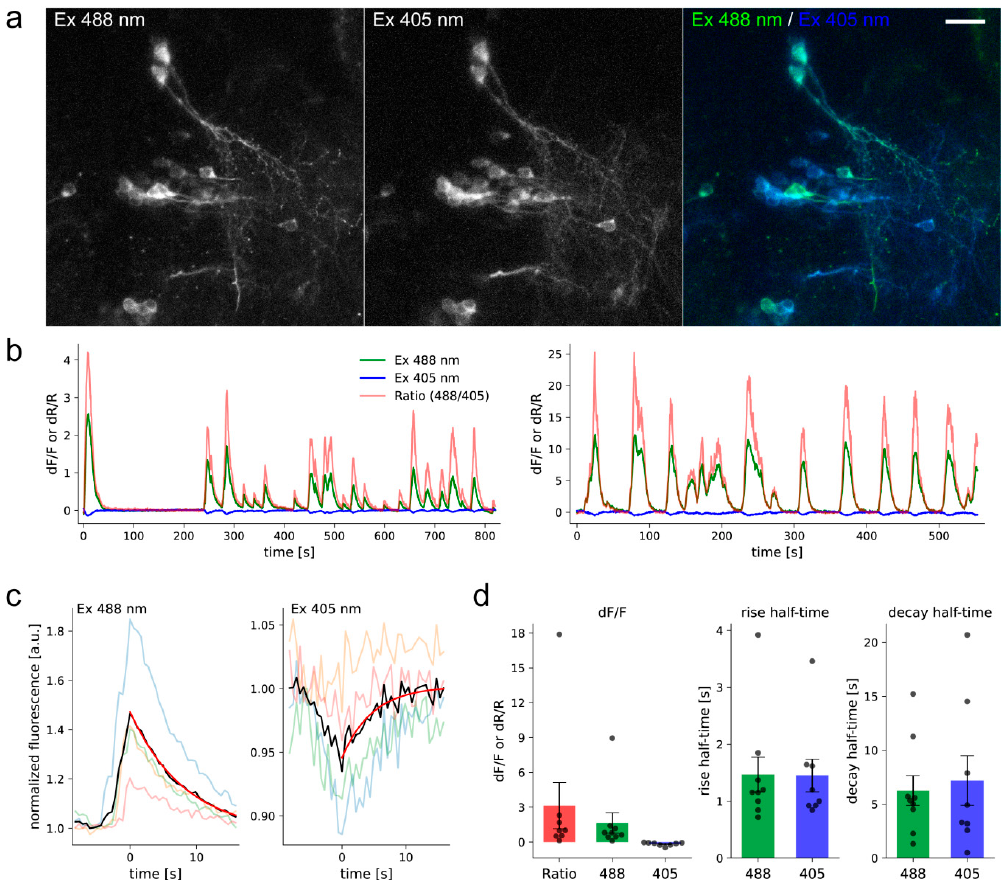
Figure 9. In vivo neuronal Ca 2+ activity in larval zebrafish brain visualized using laser-scanning confocal microscopy. ( a ) NES-FGCaMP7 transiently expressed in the larval zebrafish brain. Maximum intensity projection image at 488 (left) or 405 (middle) nm excitation, and the merged image (right; 488 in green, 405 in blue). Scale bar: 20 μ m. ( b ) Sample of Δ F/F 0 and Δ R/R 0 traces of spontaneous activity in 2 cells from 2 zebrafish larvae. Signal obtained at 488 and 405 nm excitation and their ratio (488/405) are shown in green, blue, and red lines, respectively. ( c ) Sample traces of spikes from 1 cell (pale color) and the averaged spike (black). Exponential (red) was fit to the decay of the averaged trace. ( d ) Mean of peak Δ F/F 0 or Δ R/R 0 (left), rise half-time (middle), and decay half-time (right) measured on averaged traces for 488 and 405 nm excitation and the ratio (488/405). Each dot represents a value measured in 1 cell. n = 9 for 488 nm excitation, 8 for 405 nm excitation and the ratio. Error bars indicate SEM.